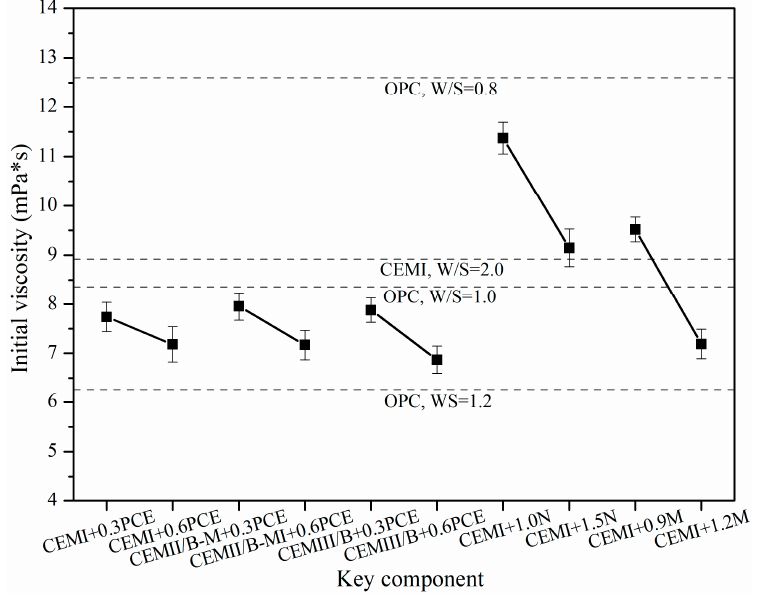
Figure 7. Effect of SP and cement type on the initial viscosity of fresh SMCG at the W/S of 1.0.